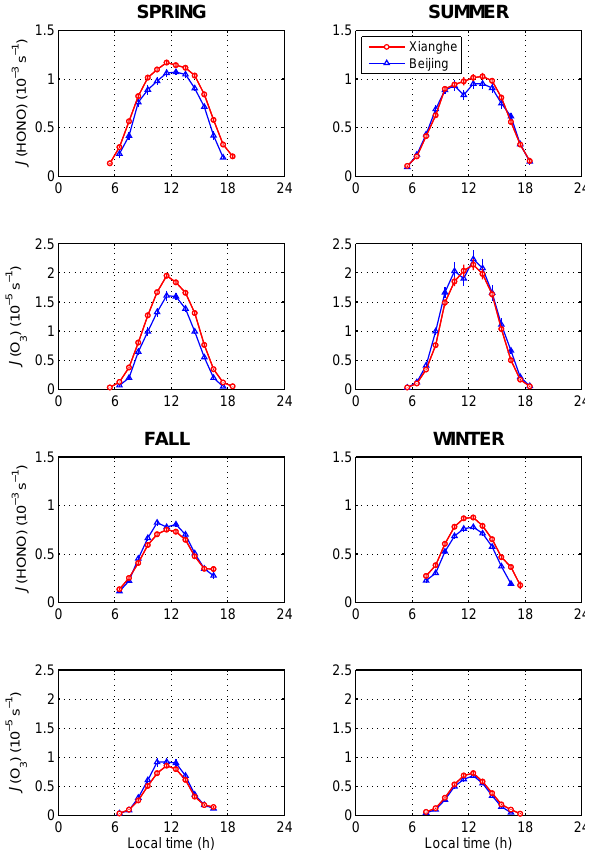
Fig. 14. Diurnal variation of the OH production from HONO ) in the 0–200m layer at Beijing (OH HONO ) and O 3 (OH O 3 (blue curves) and Xianghe (red curves). Data have been sea- sonally averaged using 1h bins. The relative contribution of HONO to the OH production (OH HONO /OH total ) is calculated as ) . The error bars correspond to the OH HONO /(OH HONO + OH O 3 standard deviation of the